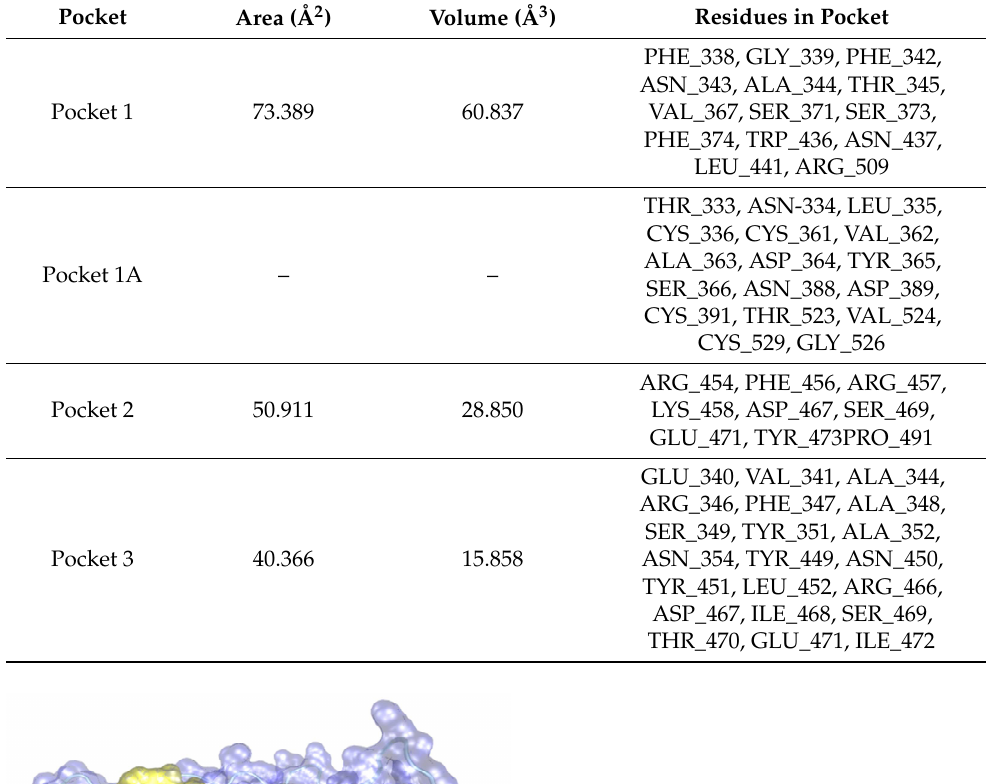
Table 1. Predicted binding sites in the receptor-binding domain.